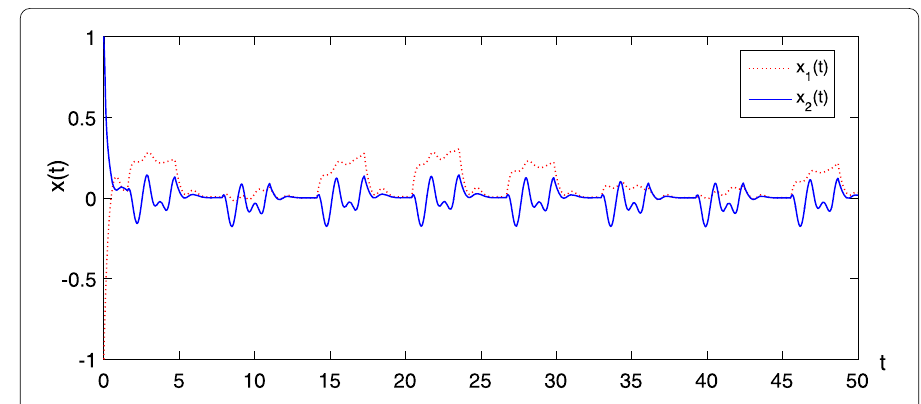
Figure 1 Simulation for Example 1 when ( T , r 1 , r 2 ) =